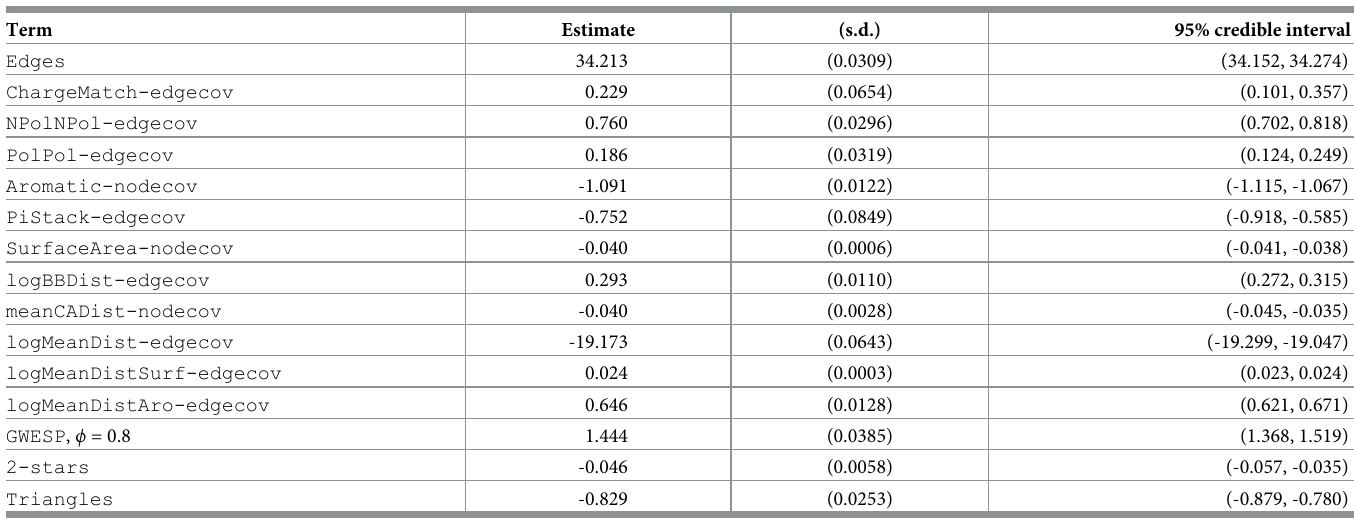
Table 9. Conjugate Bayesian analysis of Lysozyme structure